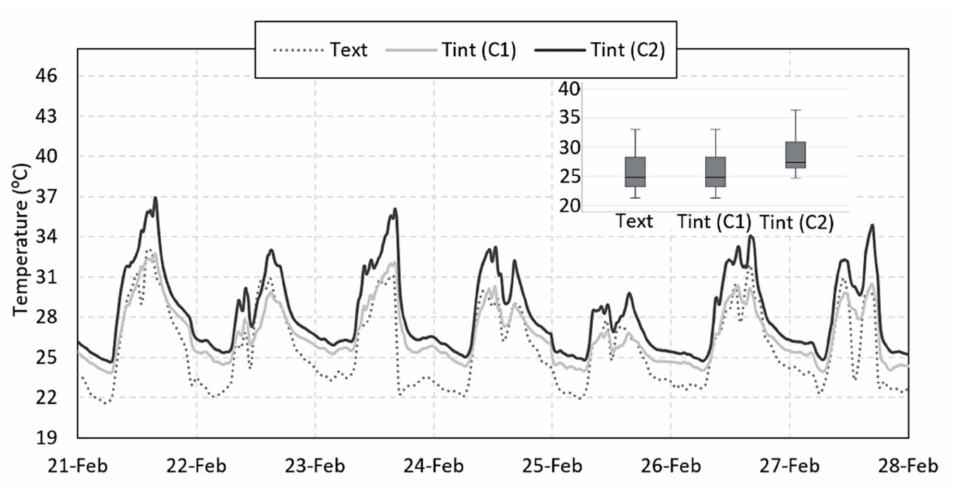
Figure 15. Variation of external and internal temperature in cells C1 and C2 during one week of campaign 5 (painting of the opaque envelope with reflective paint and natural cross ventilation by wind action for 24